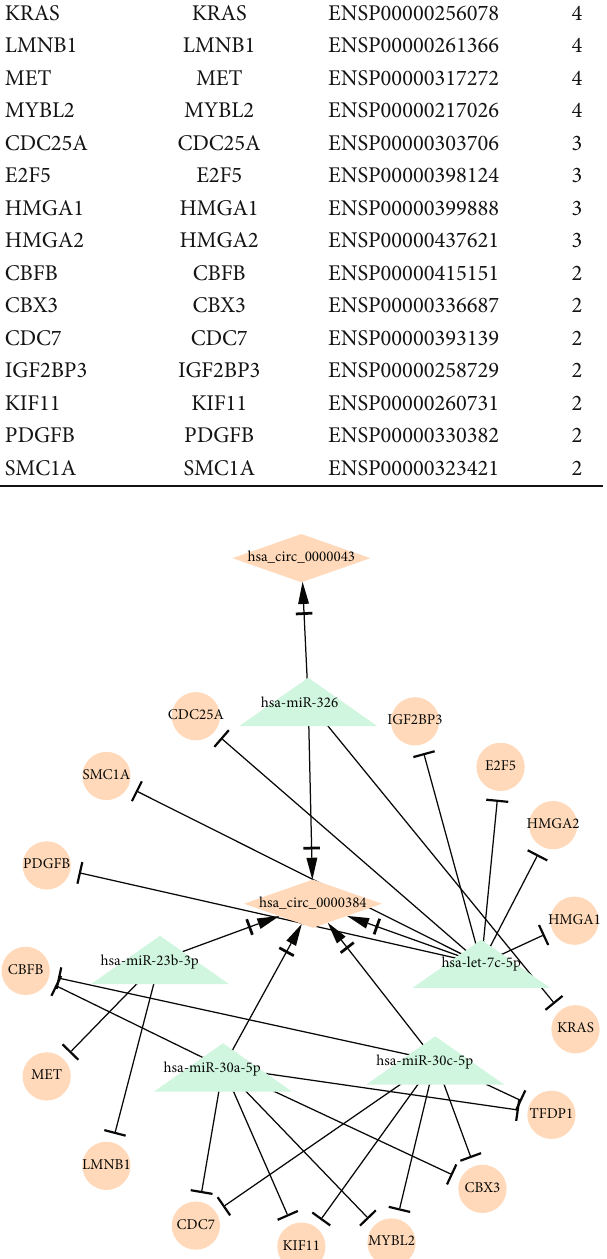
Figure 5: Construction of DEcircRNA-DEmiRNA-hub gene subnetwork.